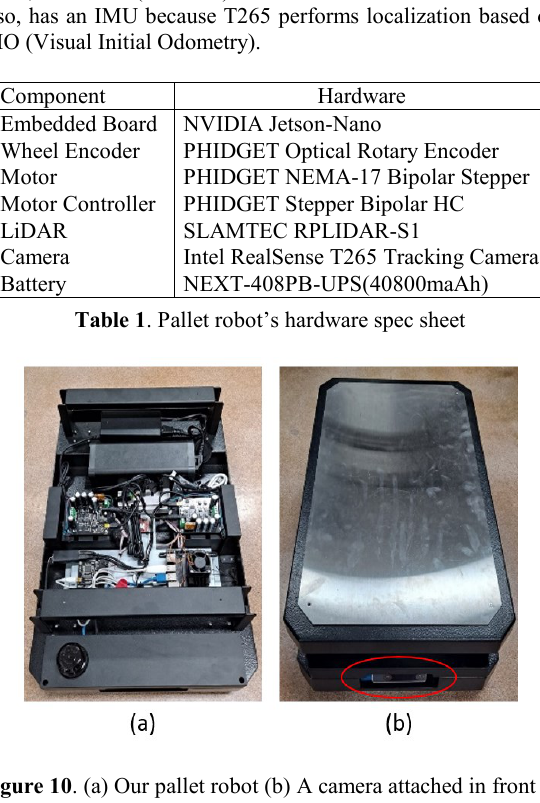
Figure 10 . (a) Our pallet robot (b) A camera attached in front of the